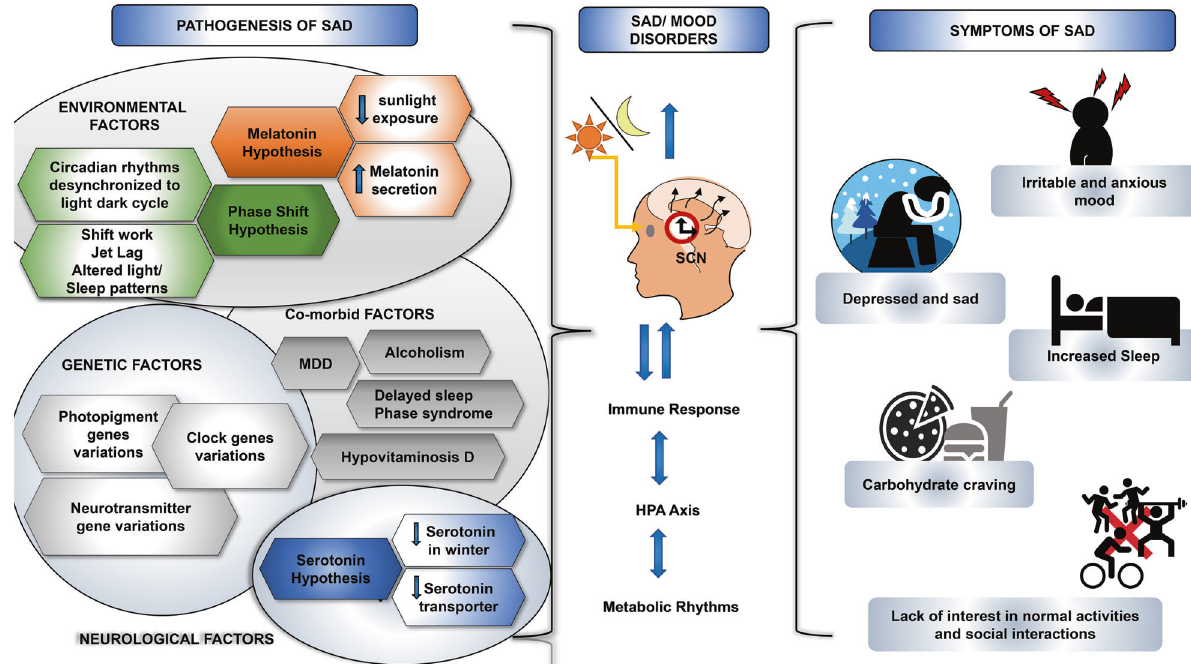
Fig. 5 The mTOR signaling pathway may be the therapeutic target of multiple antidepressants. Exposure to stress or other negative stimuli may cause depression and related disorders by inhibition of the brain mTOR activities. On the contrary, anti-depressing agents or lifestyle may work through augmenting mTOR activities directly or indirectly in the